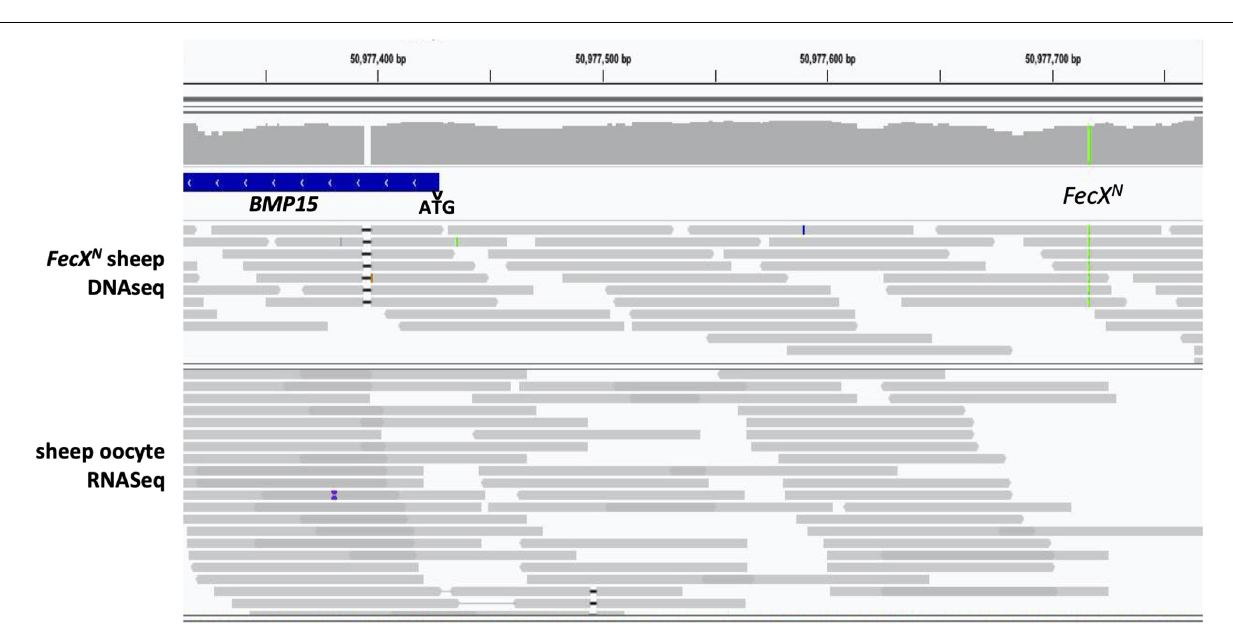
FIGURE 5 | Localization of FecX N in the BMP15 upstream region. Integrative Genomics Viewer (IGV v2.4.10) snapshot of the ovine BMP15 gene upstream region alignments (coordinates from OAR v3.1 assembly) with reads from whole genome DNA sequencing (DNASeq) of a homozygous FecX N carrier ewe (green line) and total mRNA sequencing of ovine oocytes from small antral follicles (RNASeq, Bonnet et al., 2013), indicating a possible localization of FecX N in the 5 (cid:48) UTR region of BMP15 (ATG start codon is indicated by an arrowhead and BMP15 gene annotation is on the minus